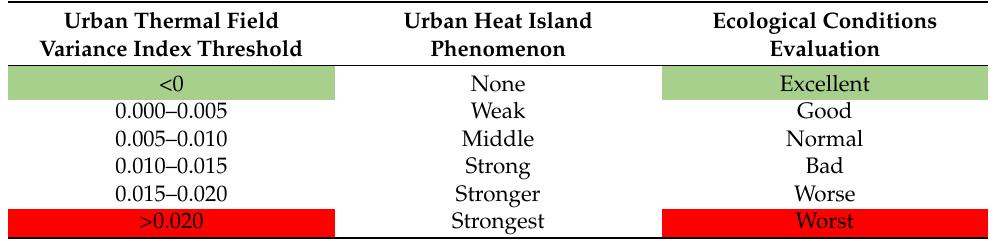
Table 2. Urban Thermal Field Variance Threshold. The colors show the excellent condition in green and worst condition in